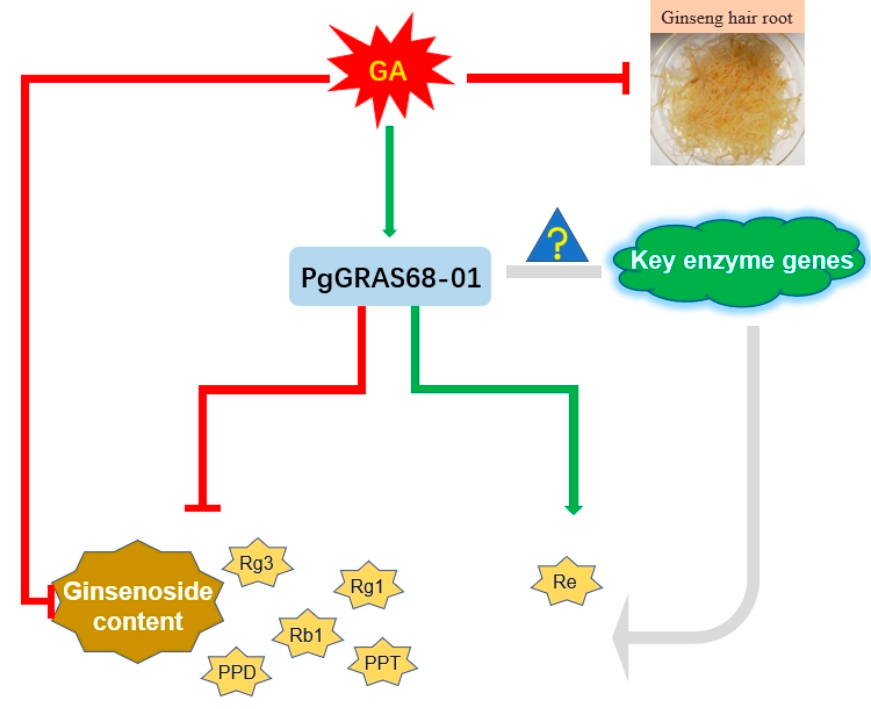
Figure 11. Mechanism of PgGRAS68-01 gene involved in ginsenoside synthesis.